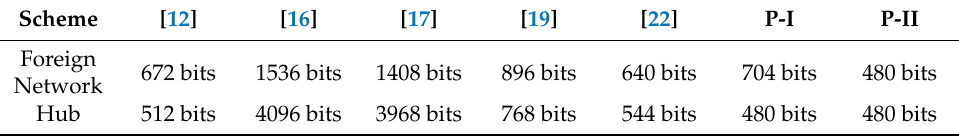
Table 8. Comparison of the scheme communication